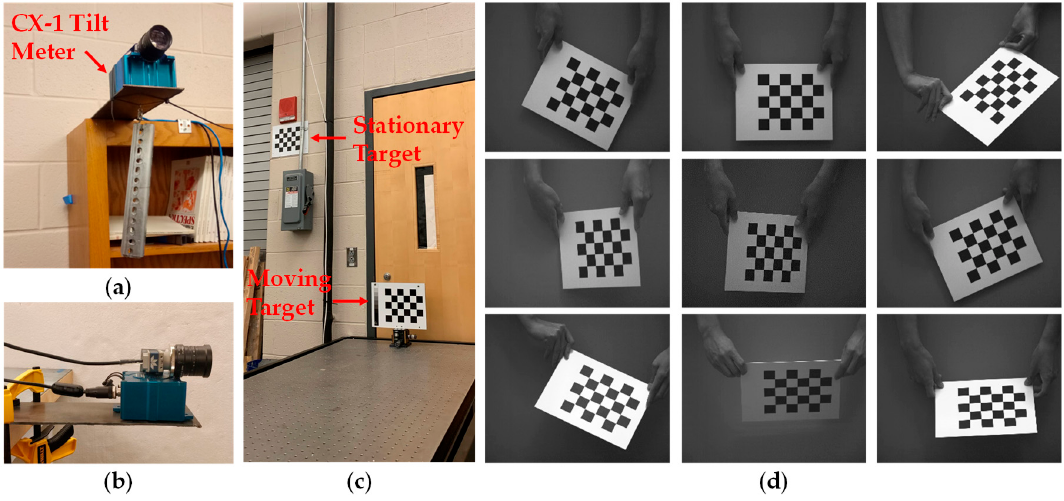
Figure 4. The simulated indoor experimental environment and samples of the captured calibration images in camera calibration: ( a ) utilized moving camera and attached tilt sensor (with weight); ( b ) utilized moving camera and attached tilt sensor (without weight); ( c ) experimental configuration of a stationary and a moving calibration targets; ( d ) samples of the calibration images, where the image intensities need not be constant due to the robust checkerboard corner detections.